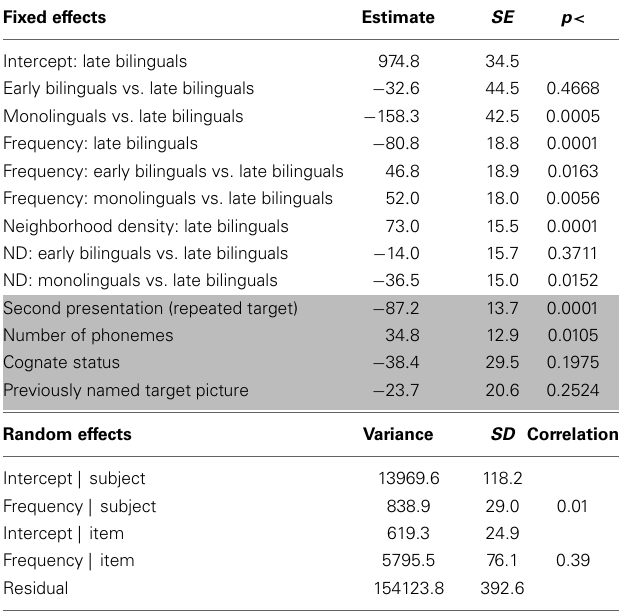
Table 2 | Results for the analysis of peak dilation